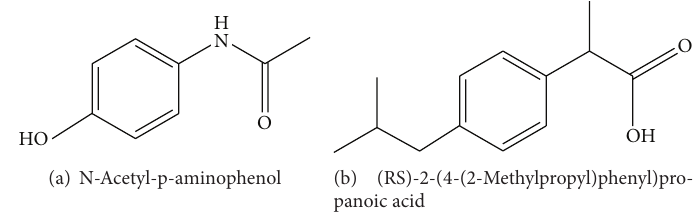
Figure 1: Chemical structure of paracetamol (a) and ibuprofen (b).